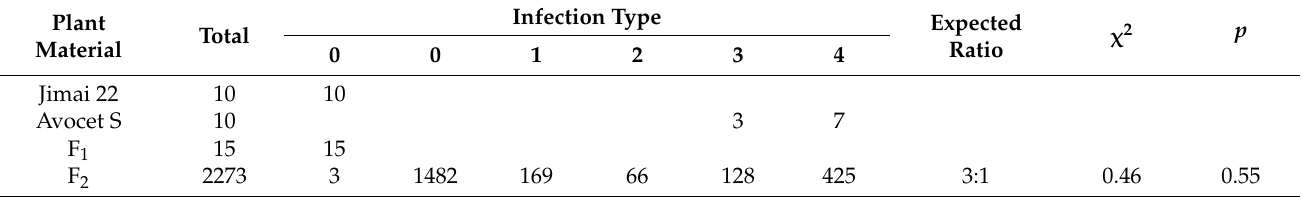
Table 1. Stripe-rust reactions to Pst race CYR32 in parent F 1 and F 2 plants.